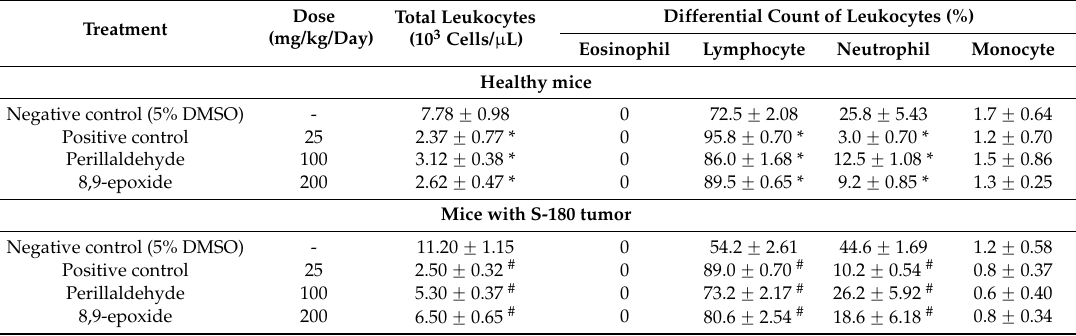
Table 3. The effect of perillaldehyde 8,9-epoxide on the hematological parameters determined through blood of healthy animals and those with S-180 tumor